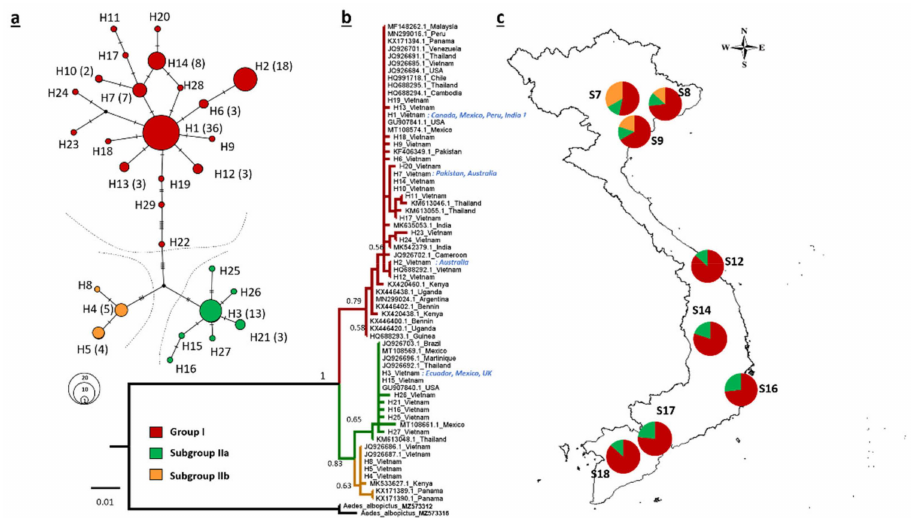
Figure 5. Population genetics of Aedes aegypti in Vietnam. ( a ) Network of COI haplotypes detected in Ae. aegypti specimens (n = 122) collected in Vietnam. Values in parentheses indicate frequencies > 1, and black dots represent inferred intermediate haplotypes. ( b ) Maximum-likelihood phylogenetic tree of COI haplotypes. Branch values indicate bootstrap values. ( c ) Distribution map of the COI haplotype